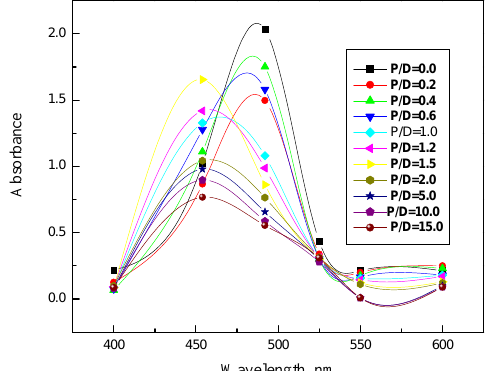
Figure 2. Absorption spectrum of MB at various concentrations